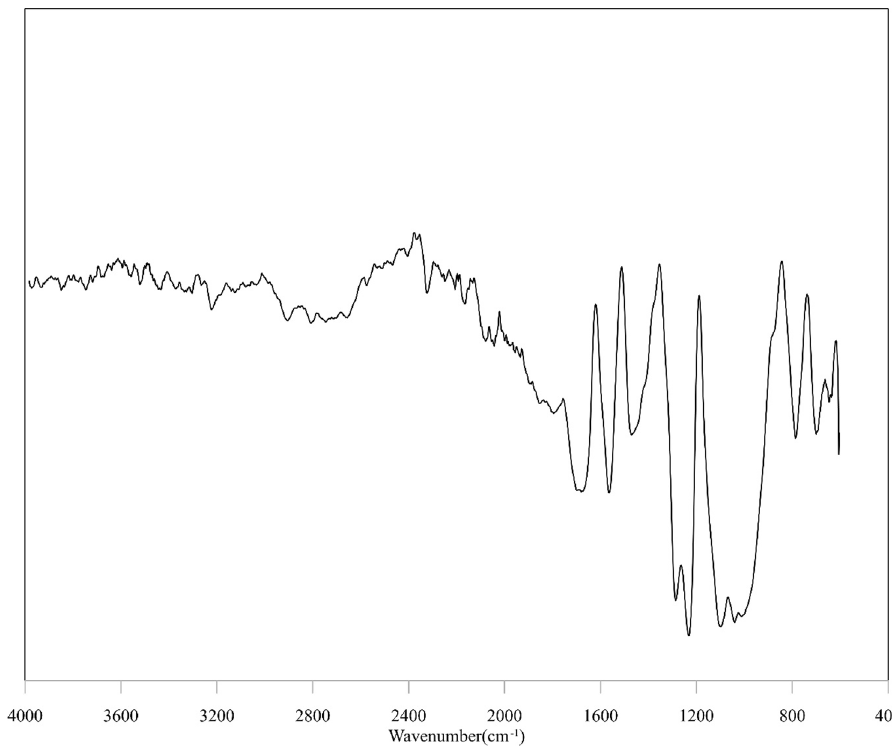
Fig. 3 AT-FTIR spectrum of PANI/2.5 wt%GNS coated fabric